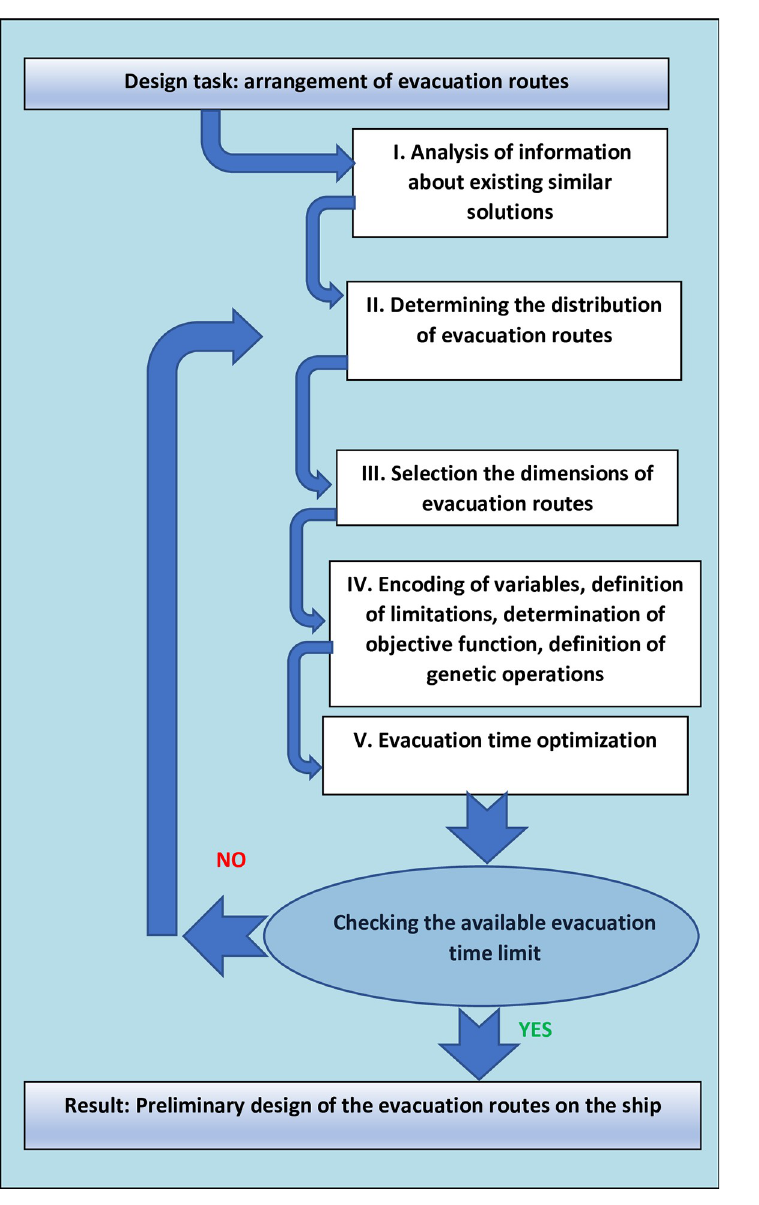
Fig 1. Diagram of the method of evacuation route validation. Source: Own